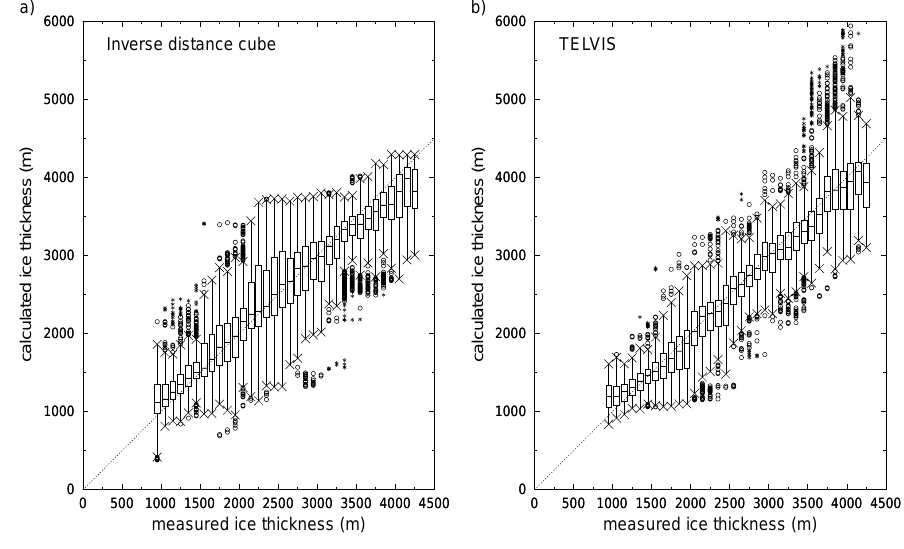
Fig. 5. Comparison between ICECAP ice thickness measurements and calculated ice thicknesses for the sparse data region of ICECAP flights to the west of Casey Station in 100m bins based on measured ice thickness. (a) inverse distance cube and (b) TELVIS. Boxes show 25th percentile, median and 75th percentile, crosses show data points furthest from median but still within ± 1.5 inter-quartile distances (IQD)(75th percentile-25th percentile) of the median, circles show data between 1.5 and 3.0 IQD of the median (outliers) and asterisk show data beyond 3 IQD of the median (extreme values). Dashed line shows ideal